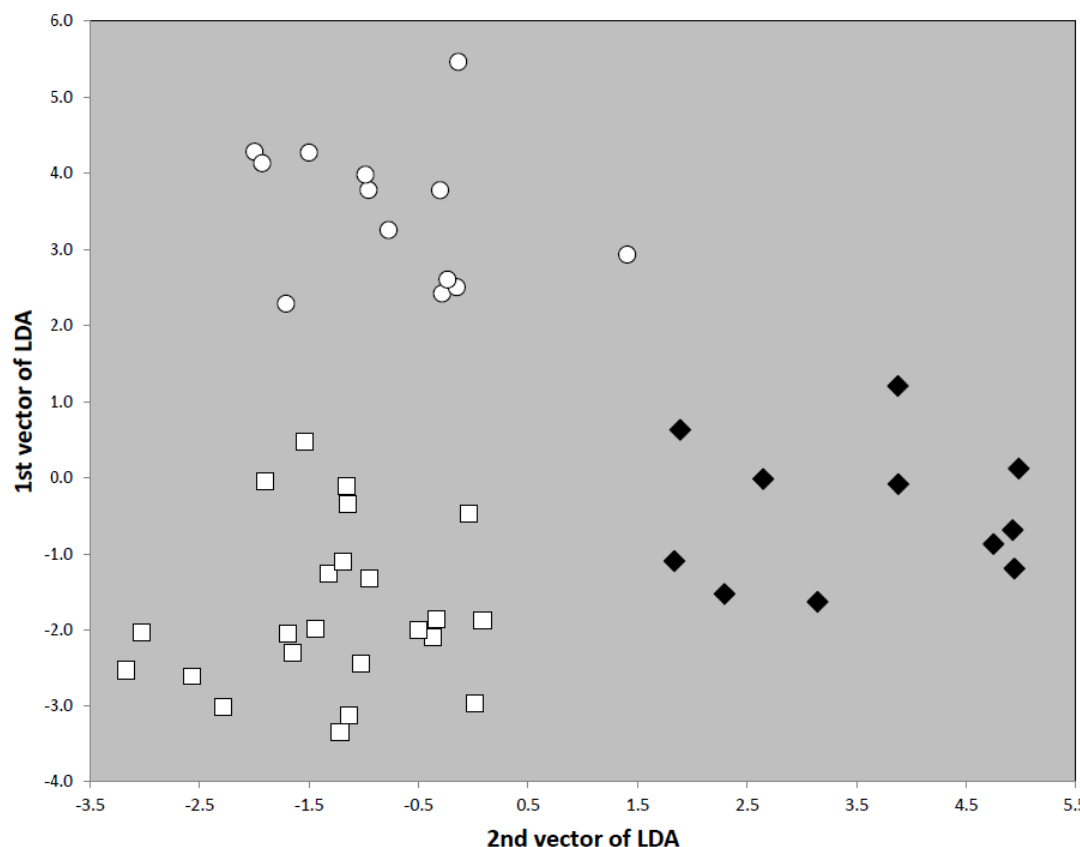
Figure 29. Separation of worker individuals of Cardiocondyla argentea n.sp. (black rhombs), C. argyrotricha n.sp. (white squares) and C. semiargentea n.sp. (white dots) by a linear discriminant analysis (LDA). In order to avoid character overfitting, the LDA was run using the first three components of a principal component analysis considering 15 morphometric characters.